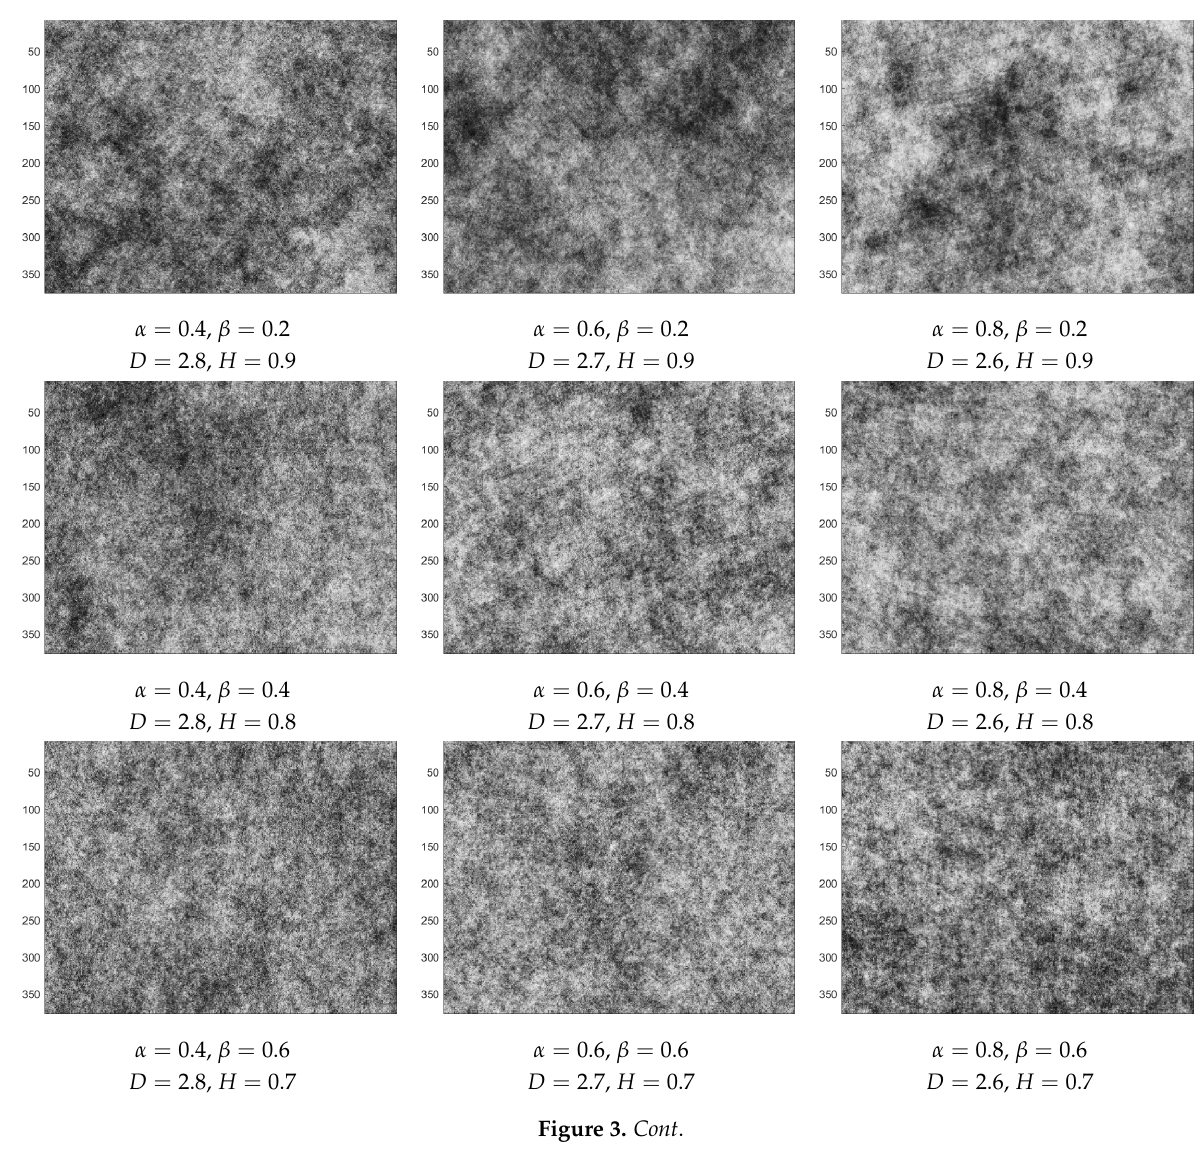
Figure 2. Realizations of Cauchy random fields with columns (from left to right) at α = 0.2,1.0,1.8 and horizontal rows (from top to bottom) β =